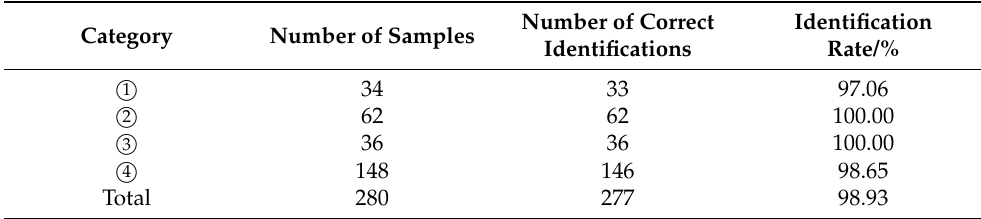
Table 1. Stem and calyx recognition